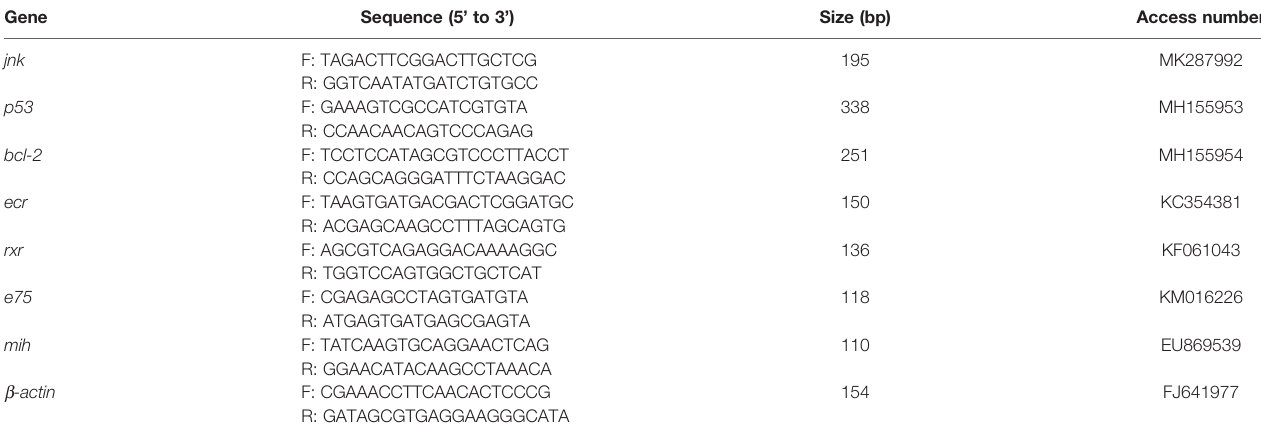
TABLE 1 | The speci fi c primers used for qPCR in this